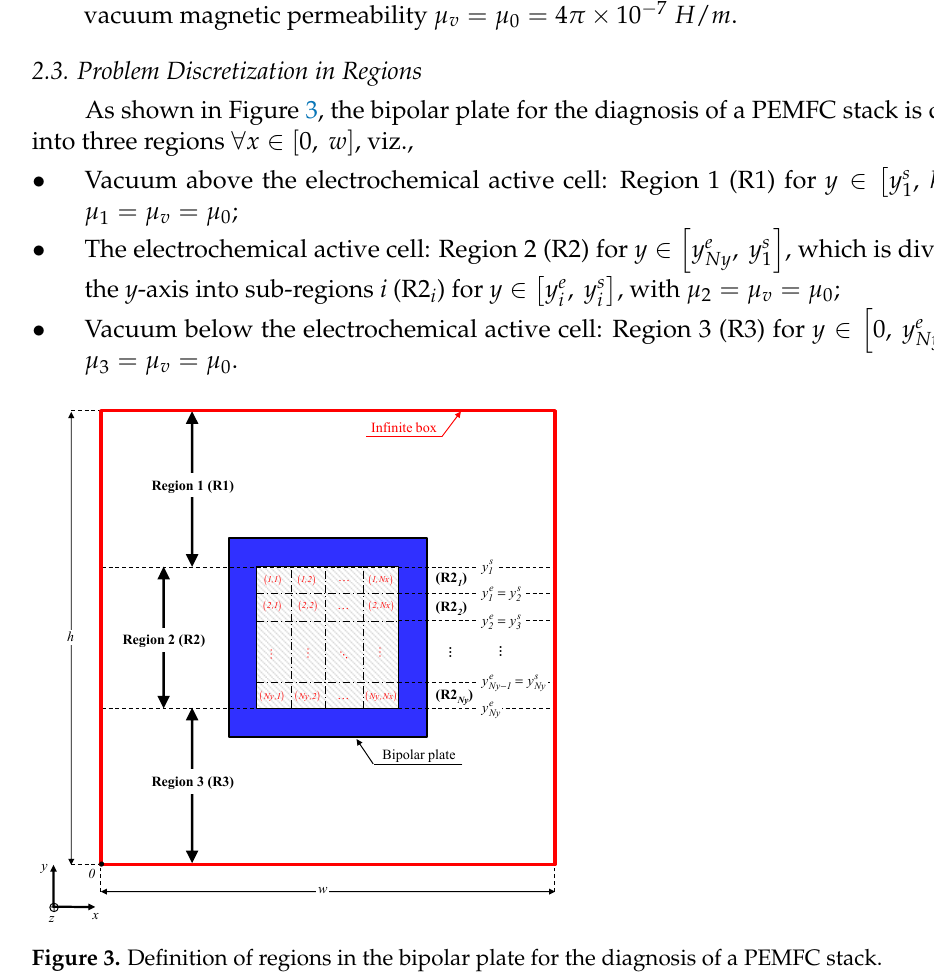
Figure 2. Waveform of the spatial distribution of zij J in any conductive segments